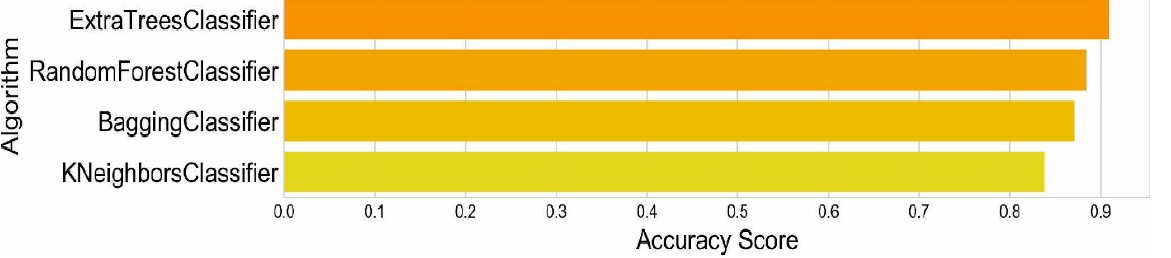
Figure 8. Ranking of ACC scores after model optimization.